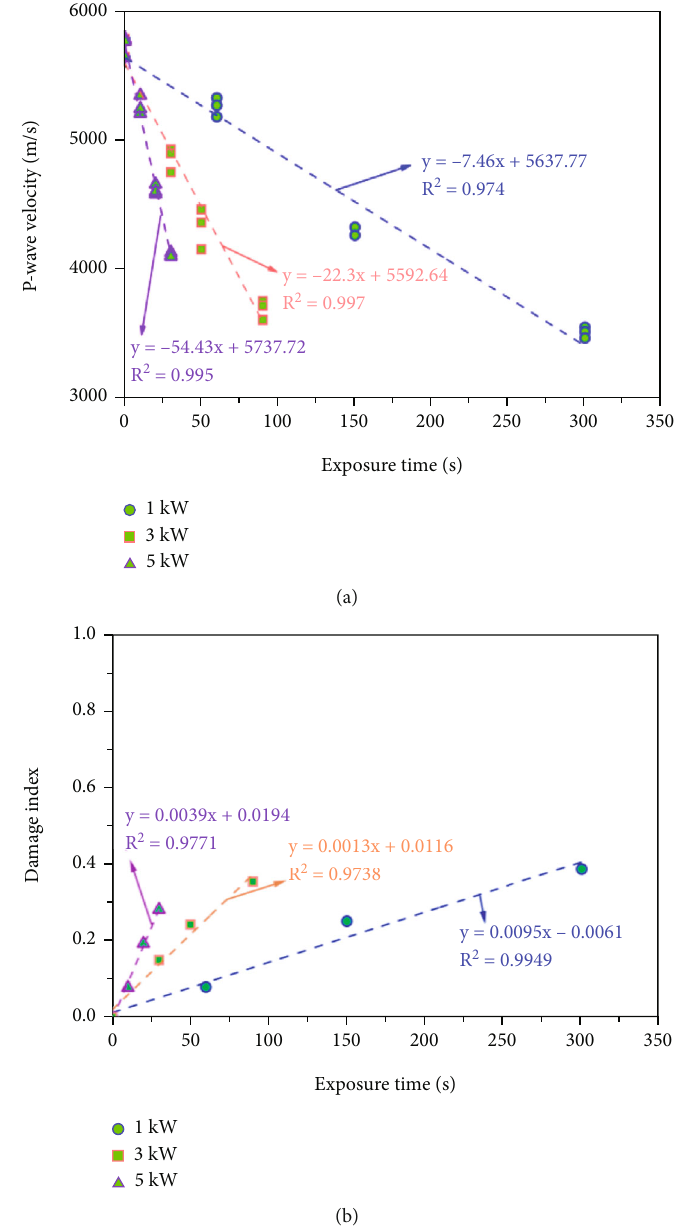
Figure 4: Ultrasonic wave propagation induced by microwave irradiation: (a) velocity of P-wave and (b) damage index based on the